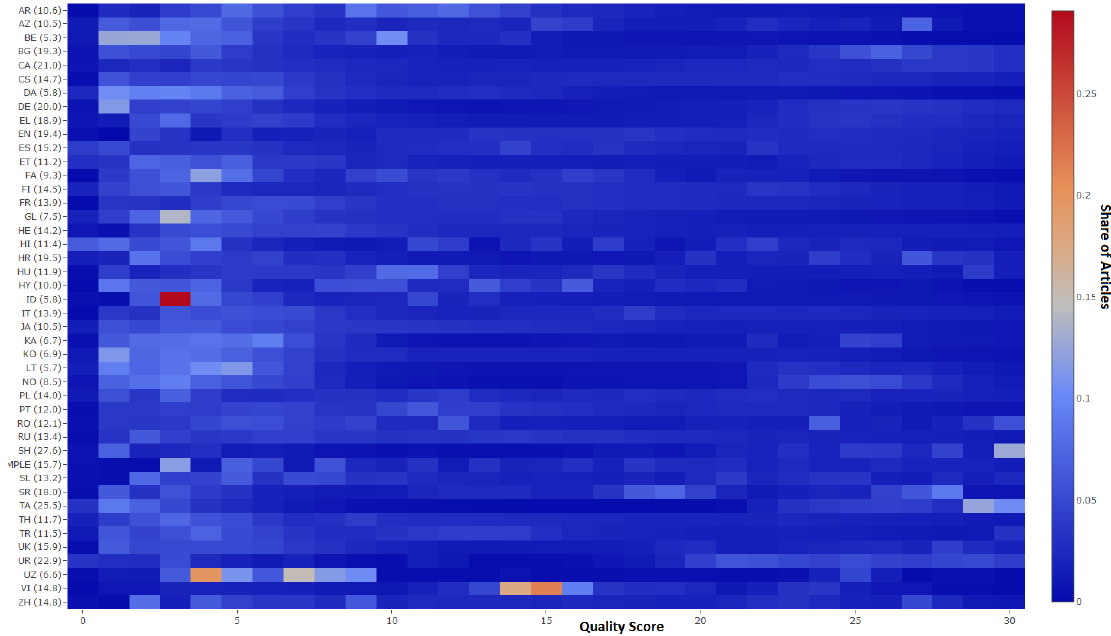
Figure 2. Distribution of articles depending on quality score in each language version of Wikipedia. The medians of the quality scores for each language edition are in parentheses. Source: own